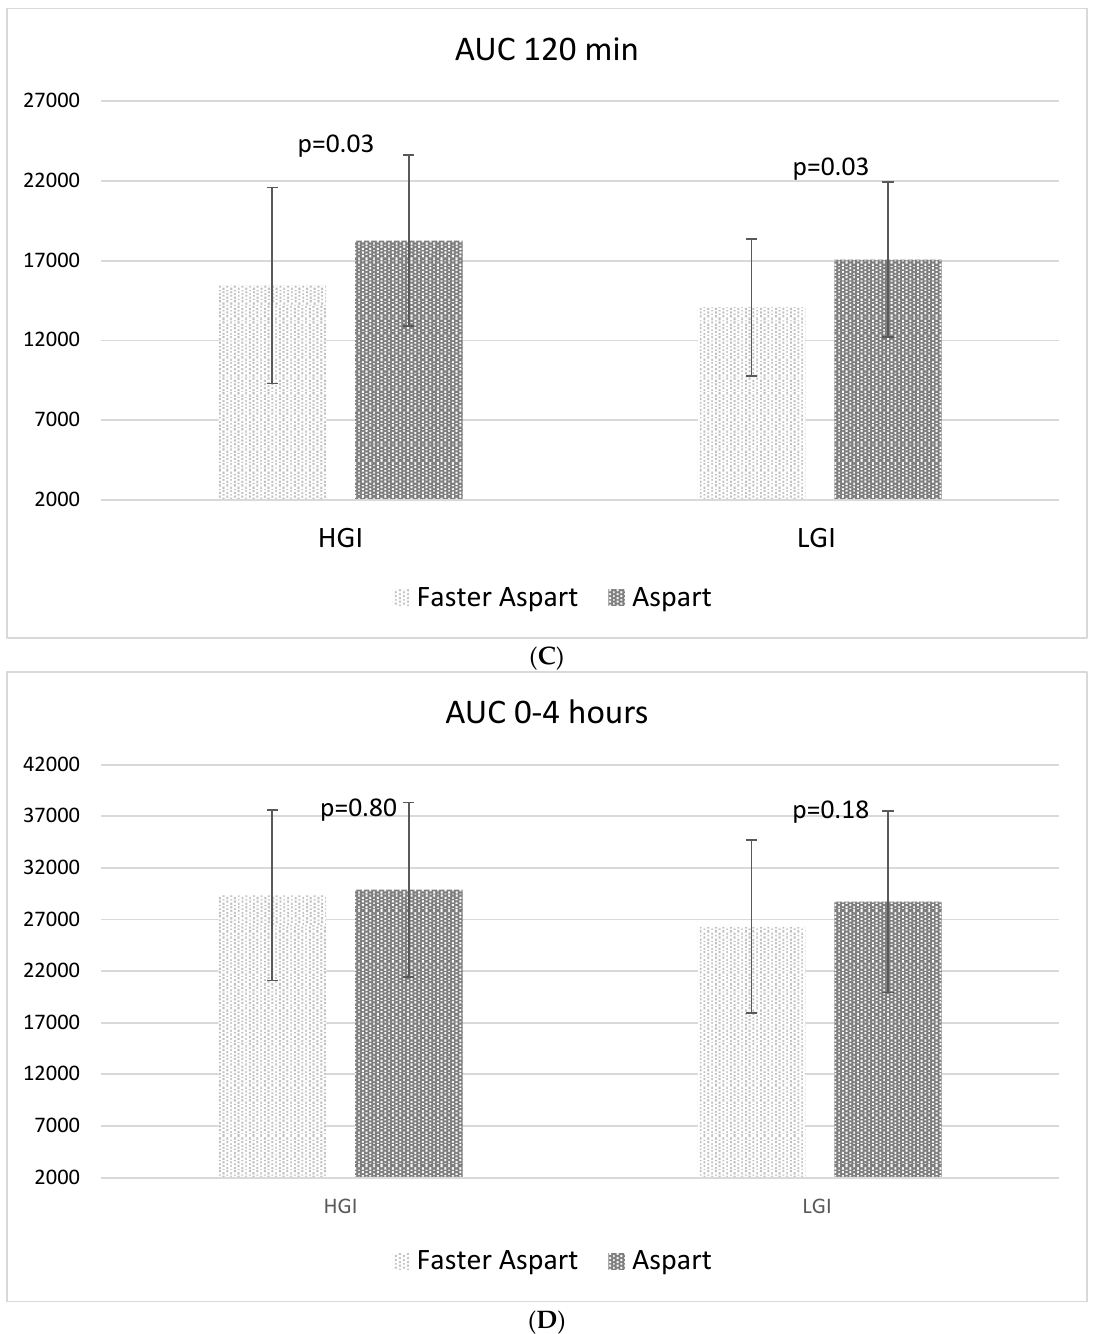
Figure 2. Glucose Area Under the Curve (AUC) in the ( A ) 30 min, ( B ) 60 min, ( C ) 120 min, and ( D ) 4 h following the meal tests.